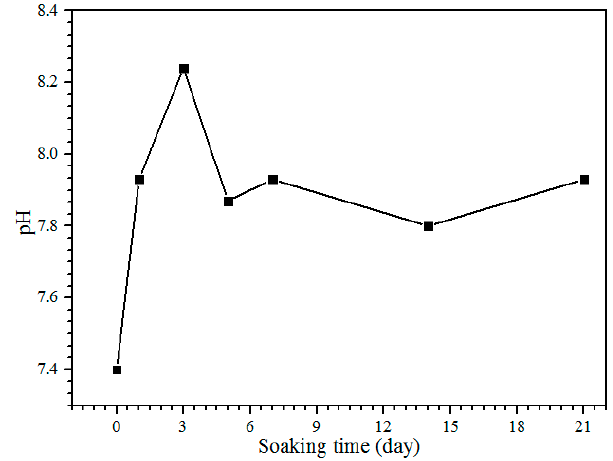
Figure 7. The pH of the SBF solution after each day of the soaking.